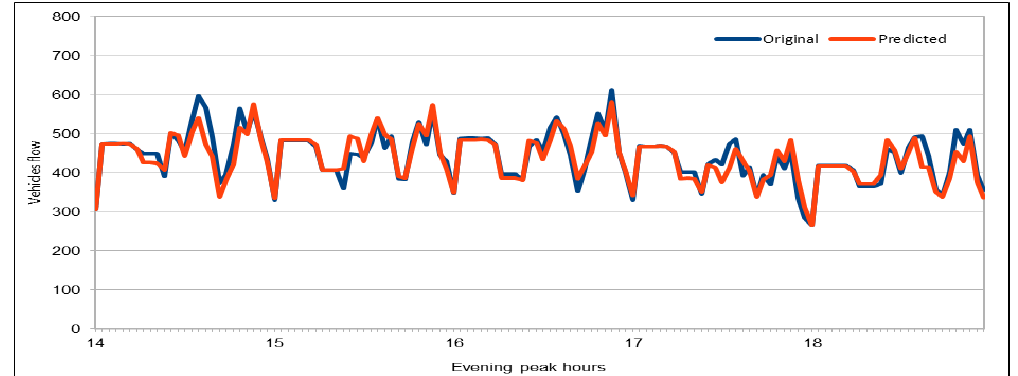
Figure 22. Comparison of original and predicted flow values on evening peak